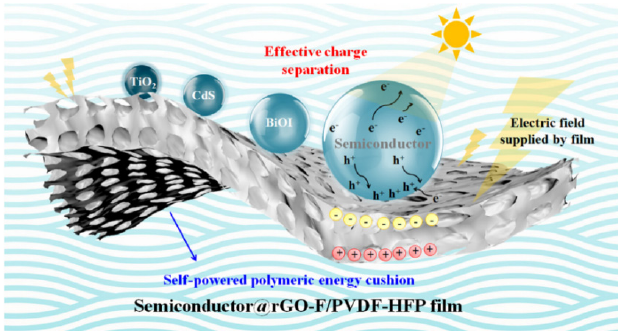
Figure 16. Schematic illustration of the design concept of the hybrid piezophotocatalyst (Reprinted/adapted with permission from Ref. [171]. Copyright 2018, copyright Elsevier).